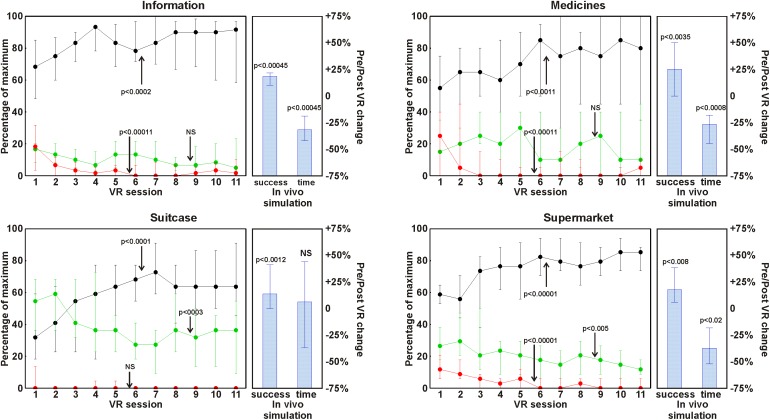
Changes along the VR training sessions in number of correct responses (black circles and lines), incorrect responses (green circles and lines), and no-responses (red circles and lines). The data are reported as a percentage of the maximum for each parameter in each app and are shown as median (circles) and interquartile range (whiskers). The histograms on the right of each line plot show the results of the in vivo tests expressed as a pre/post change in median percentage (columns) and interquartile range (whiskers).